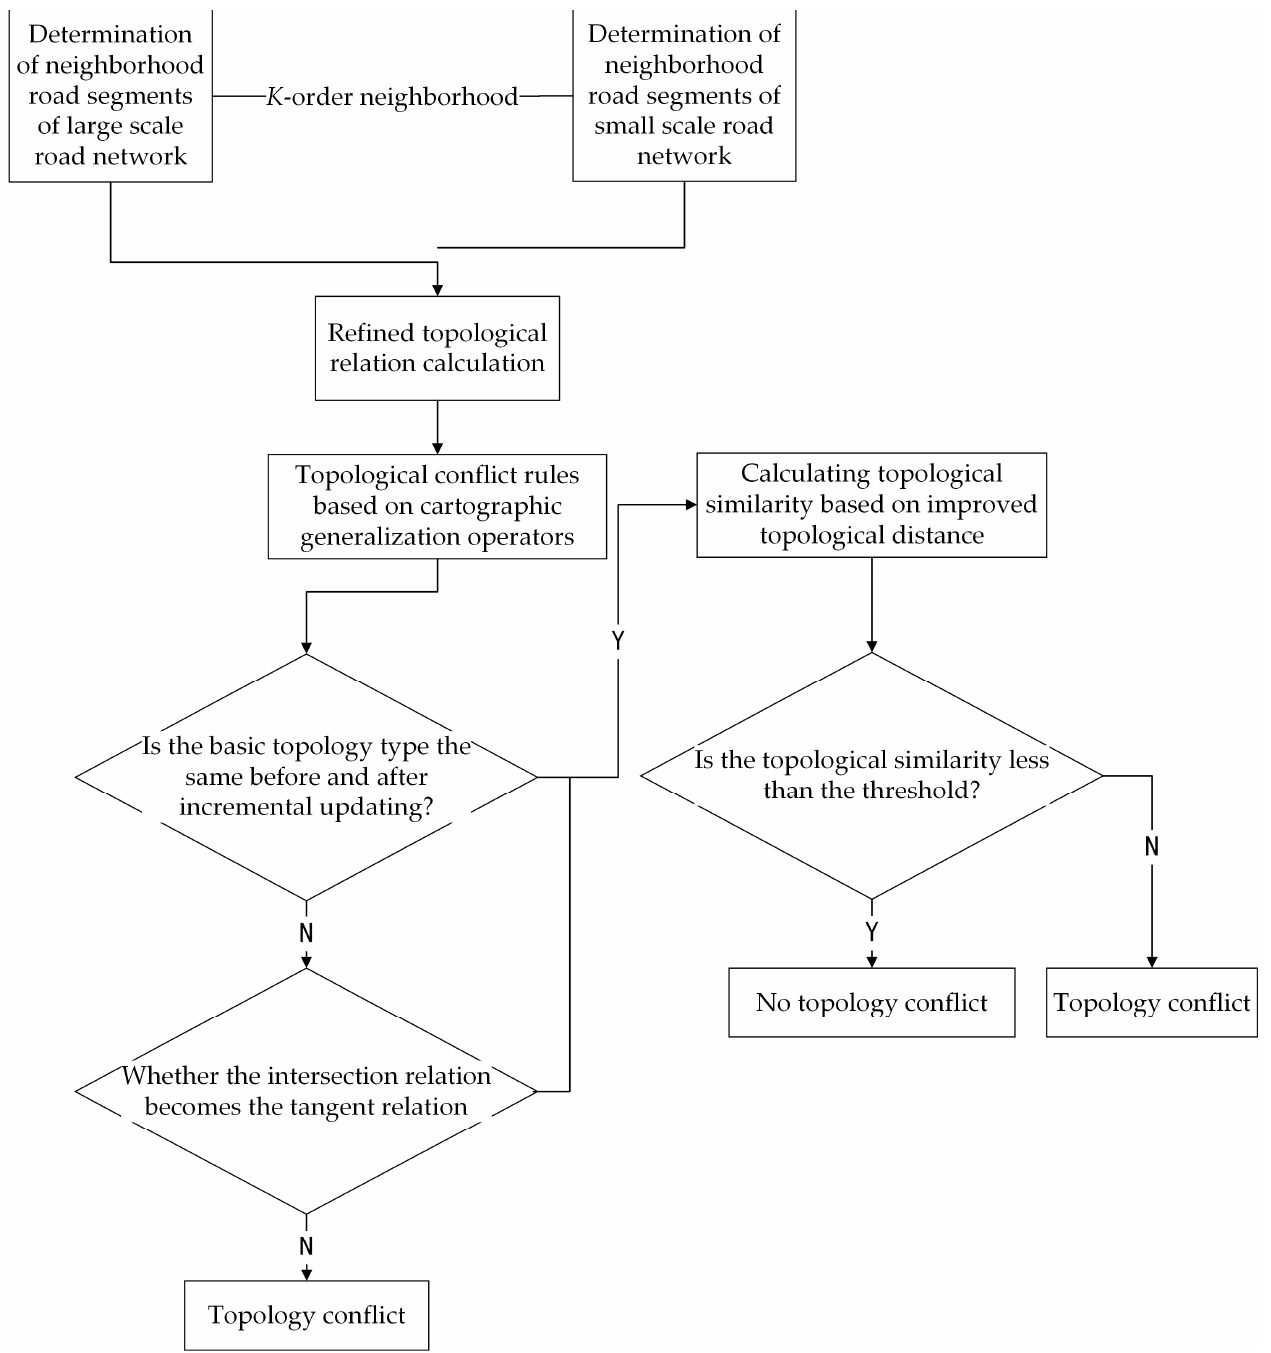
Figure 5. Topology conflict detection process based on topology consistency.